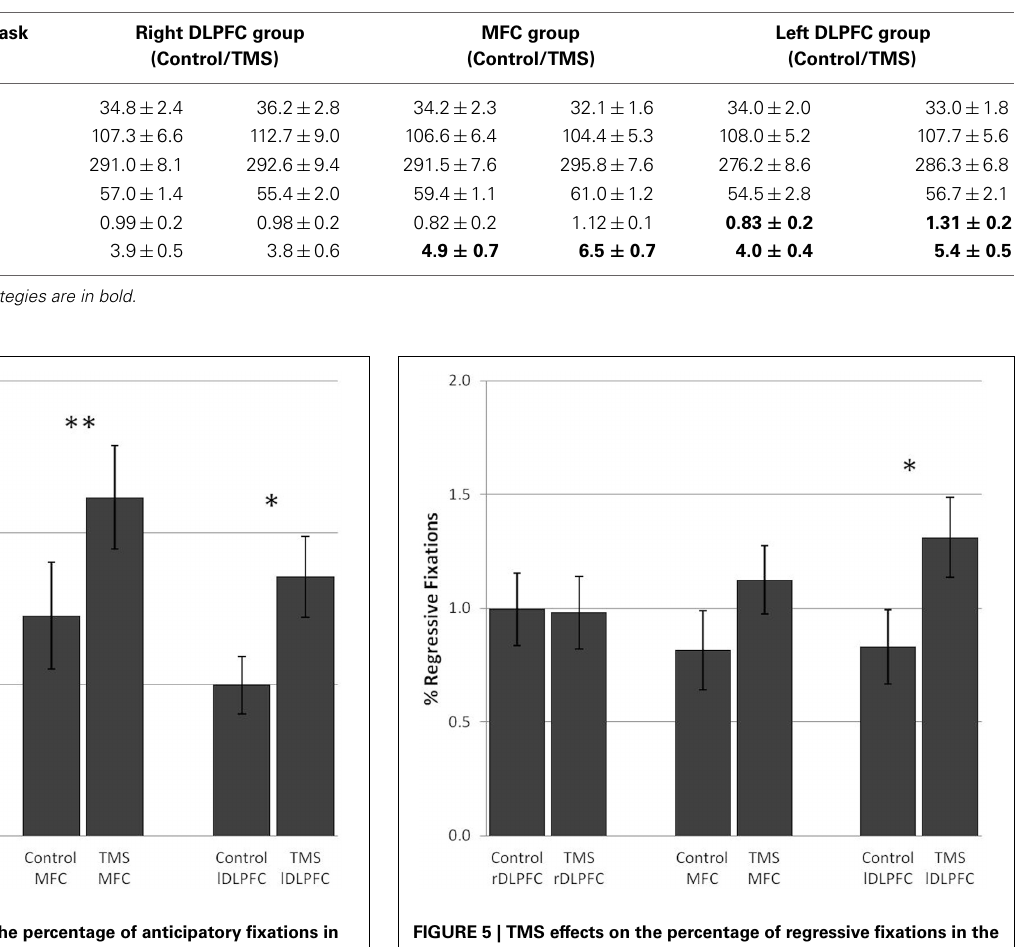
FIGURE 4 | TMS effects on the percentage of anticipatory fixations in the number and letter search task. Significant differences in anticipatory fixations between the control and TMS conditions were found in the medial frontal cortex TMS group and the left dorsolateral prefrontal cortex TMS group. Error bars indicate standard errors of the mean (SE). ∗ 0.015; ∗∗ 0.007.